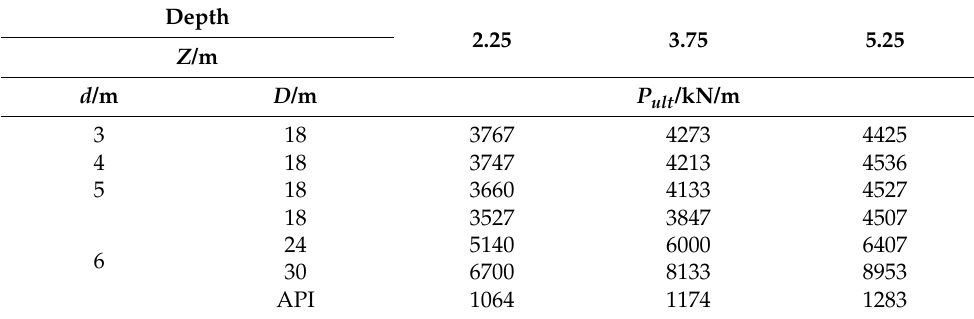
Table 8. Lateral ultimate soil